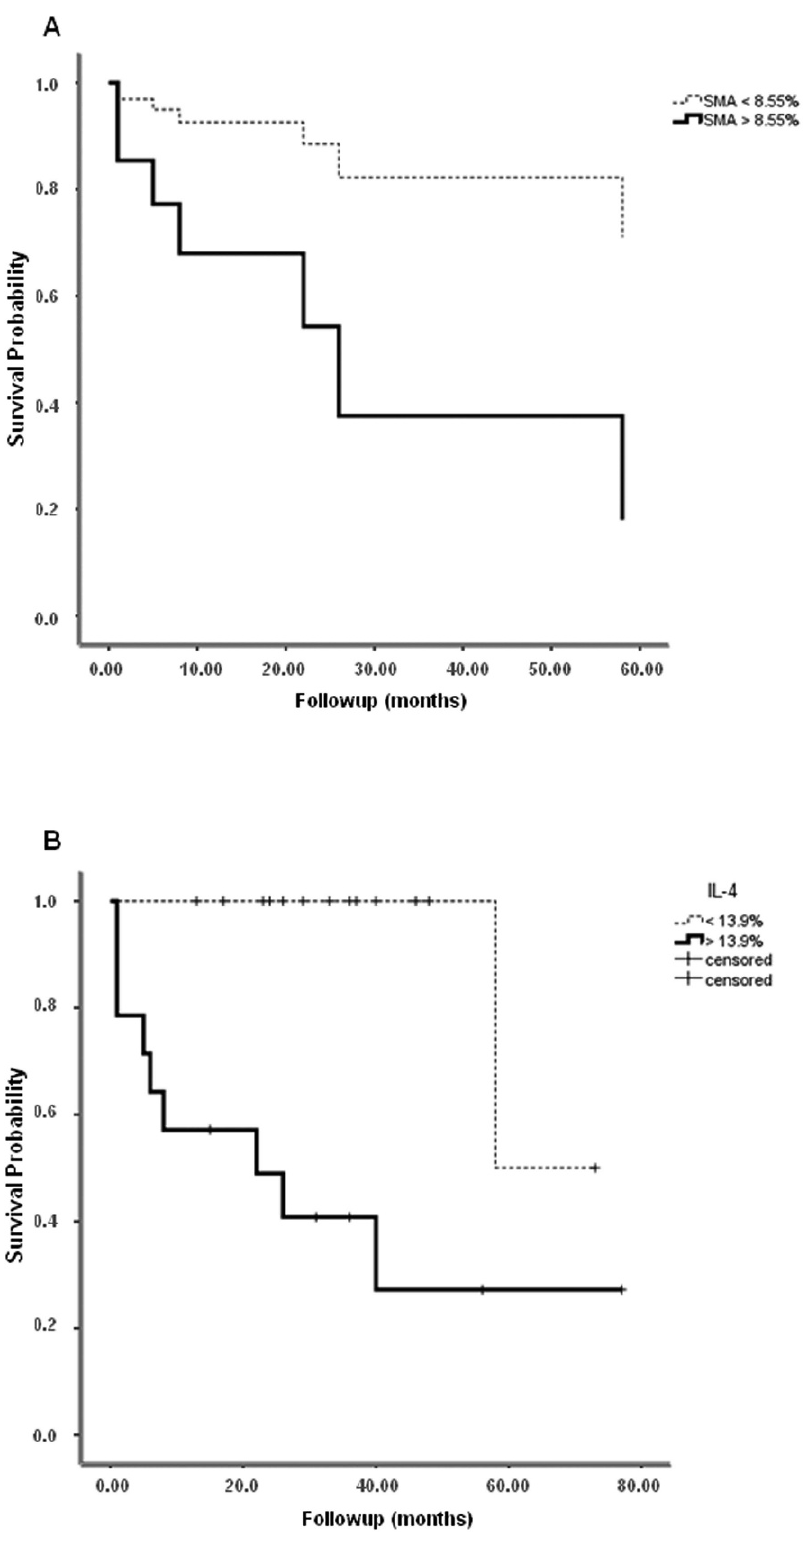
Figure 3 - Cox multivariate analysis plots of survival probability versus follow-up time in months for patients . 68 years with FVC , 66%. Patients with myofibroblast a -SMA expression lower than 8.55% (A) or with IL-4 tissue expression lower than 13.9% (B) in areas of mural fibrosis appear as the top